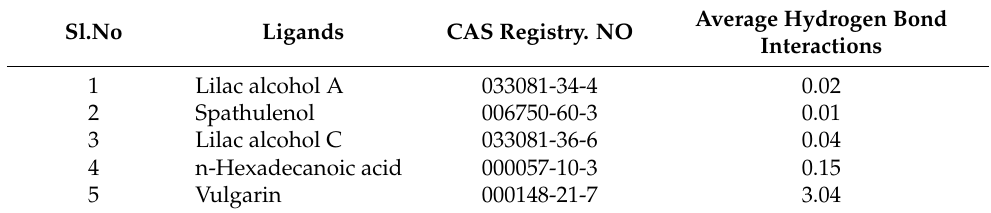
Table 5. Average number of hydrogen bond interactions of MDR Ab-EP and ligand complexes at 50 ns.